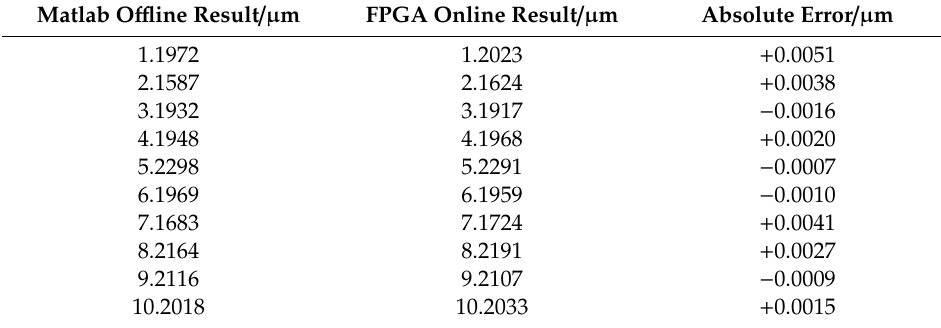
Comparative analysis of o ffl ine result obtained using MATLAB and FPGA results obtained online. Matlab O ffl ine Result / µ